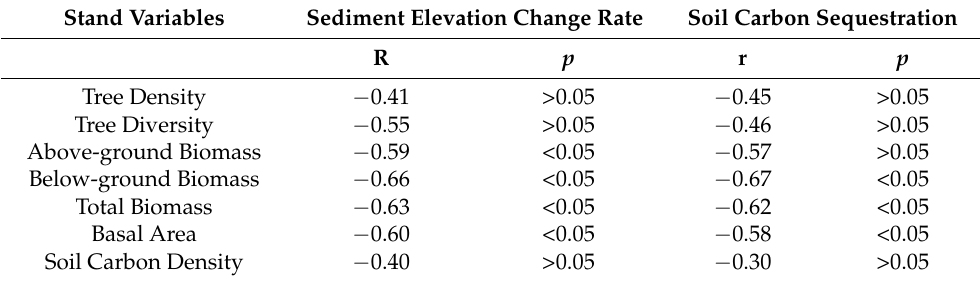
Table 6. Summary table of Pearson product-moment correlation coefficients